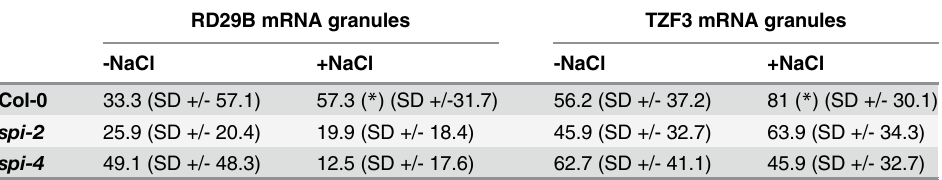
Table 3. mRNA granules localize to P-bodies (related to Fig 9). mRNA accumulations overlap with P- bodies under nonstress (-NaCl) and salt stress (+NaCl) conditions. Data denote the average (in %) of 65 cells (RD29B) or 120 cells (TZF3).